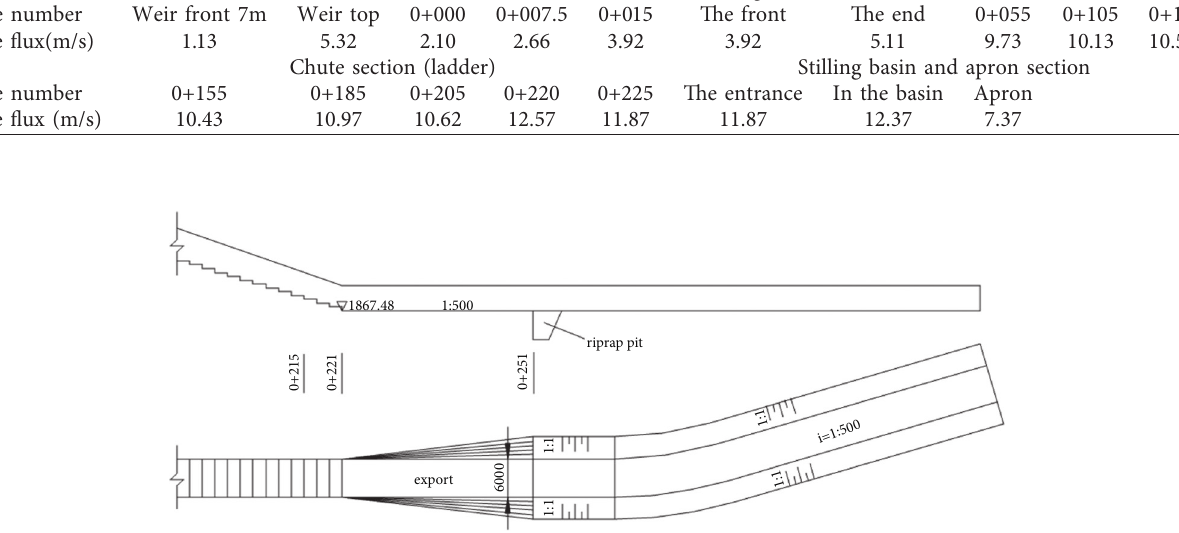
Figure 8: Schematic diagram of the improved